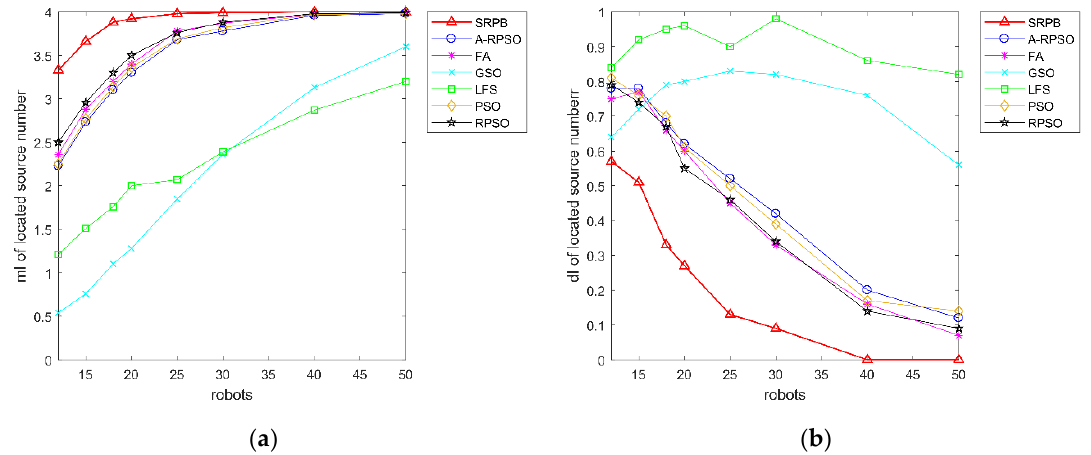
Figure 11. The number of located sources with different population sizes and the different initial positions of robots. ( a ) mI of the number of located sources; ( b ) dI of the number of located sources.